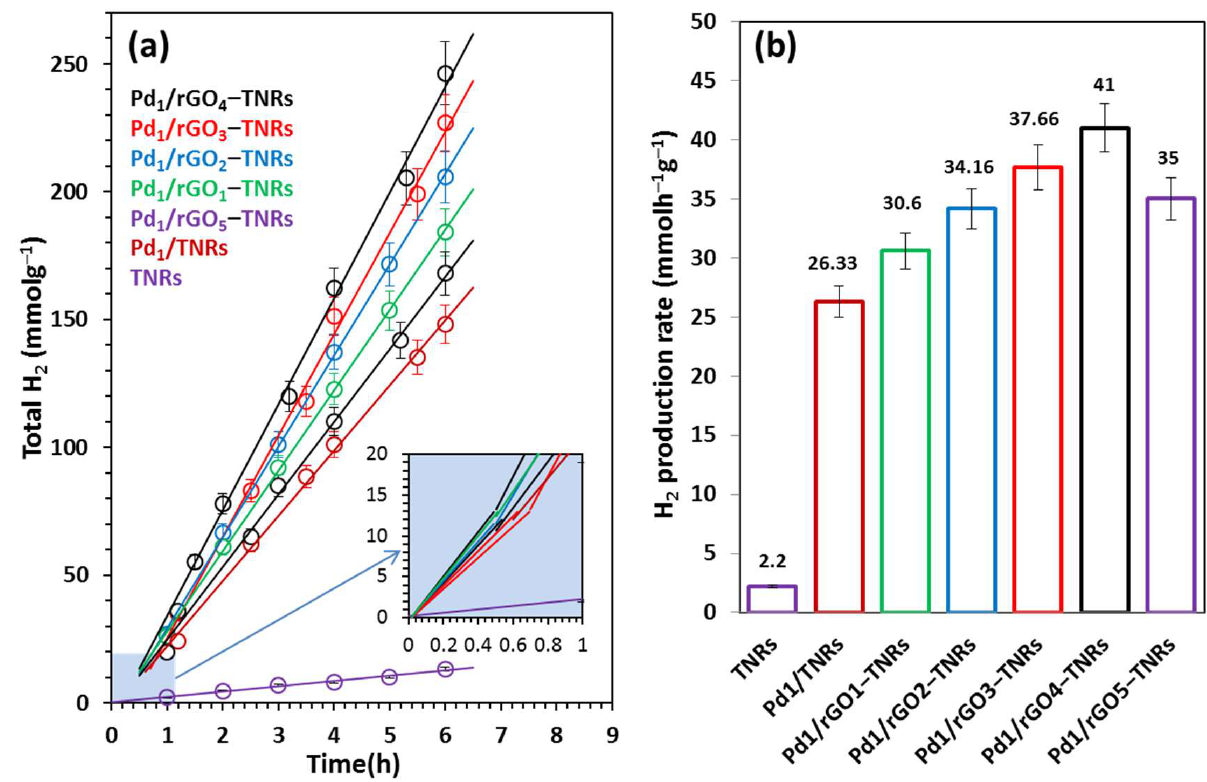
Figure 6. Comparison of H 2 production over TNRs, Pd 1 /TNRs, Pd 1 /rGO 1 −TNRs, Pd 1 /rGO 2 −TNRs, Pd 1 /rGO 3 −TNRs, Pd 1 /rGO 4 −TNRs and Pd 1 /rGO 4 −TNRs photocatalysts in 5 vol% glycerol/water mixtures. Figures ( a ) and ( b ) show the total amount of H 2 production as a function of time and H 2 production rates for different catalysts, respectively. The inset in ( a ) highlights the induction peri- od.